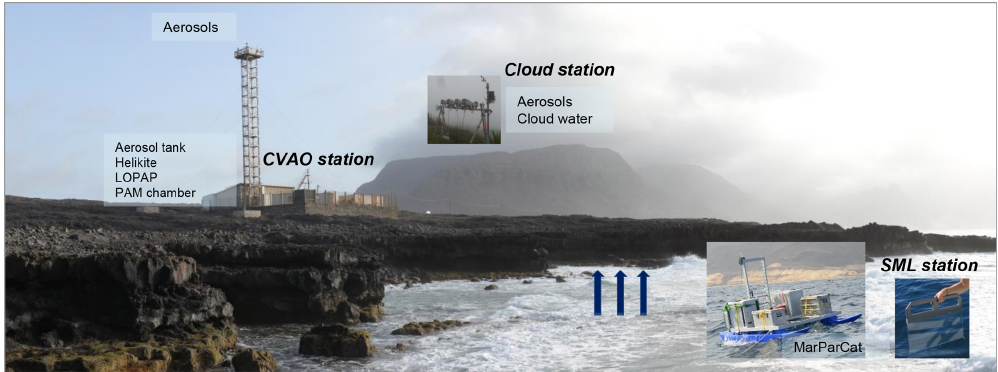
Figure 1. Illustration of the different sampling sites during the campaign. Table 1. Classification of the air masses according to dust concentrations from the impactor samples after the calculation of dust concentra- tions according to the Fomba et al. (2014) sample and under the consideration of backward trajectories (Fig. 2). Start local time Stop local time Dust conc. Classification (yyyy/mm/dd, UTC − 1) (yyyy/mm/dd, UTC − 1) (µgm − 3 )